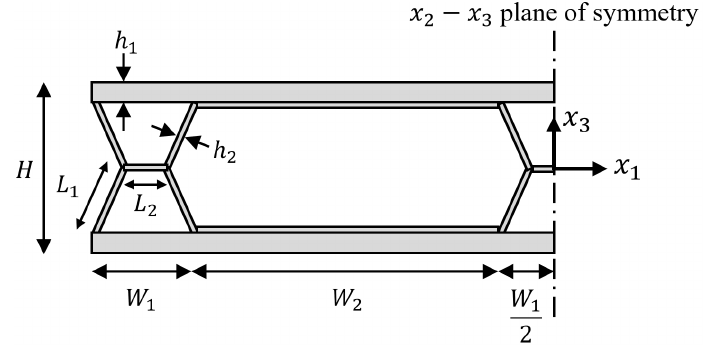
Figure 14. A simplified version of the canard cross-section